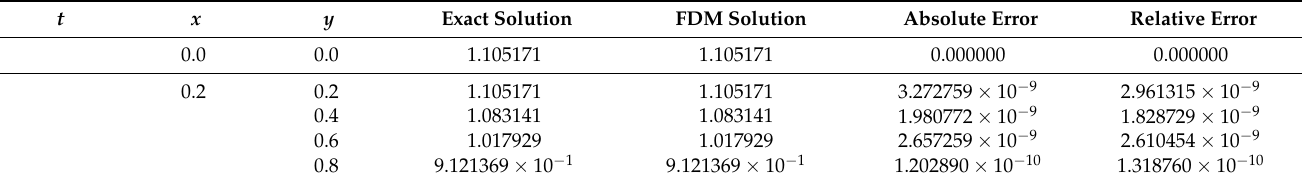
Table 4. A comparison between the exact solution and FDM solution at some values of x and y at times t = 0.10, 1.0, 2.0 (Experiment